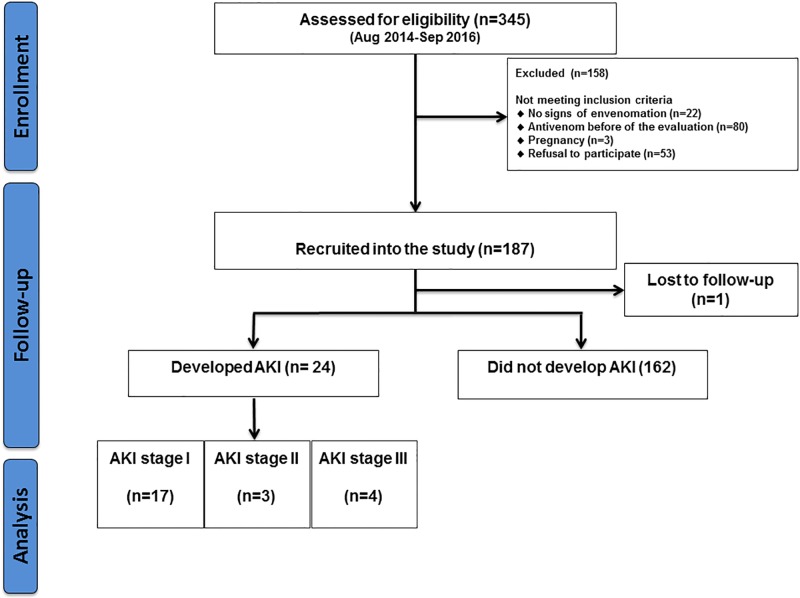
Flowchart of inclusion of patients admitted at FMT-HVD following Bothrops snakebite.